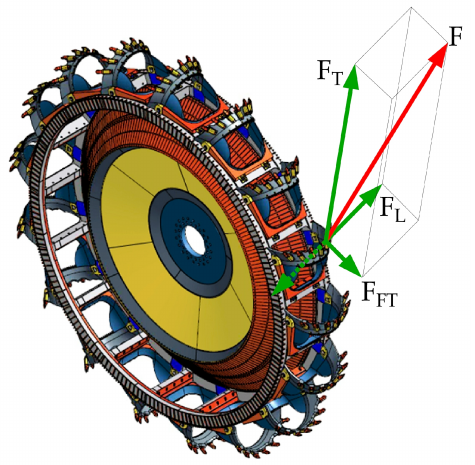
Figure 1. Digging force components (F T —tangential, F L —lateral, and F FT —forward thrust).